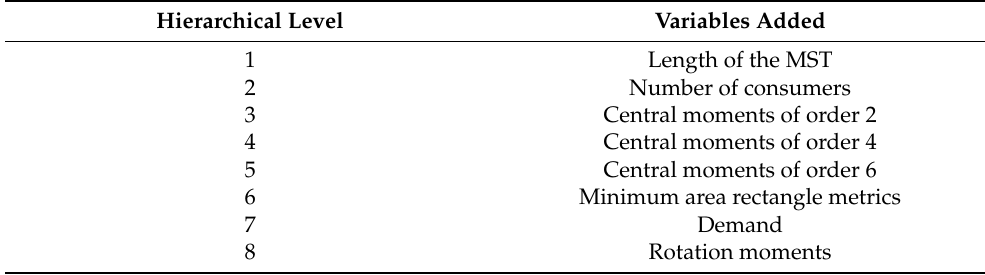
Table 2. Models used in the hierarchical regression. Hierarchical